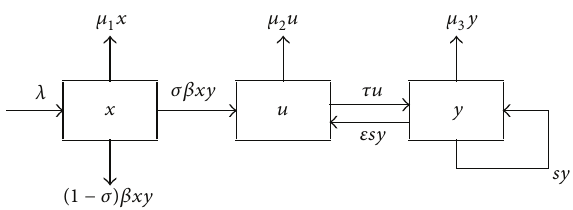
Figure 1: The schematic diagram of the HTLV-1 infection in vivo.